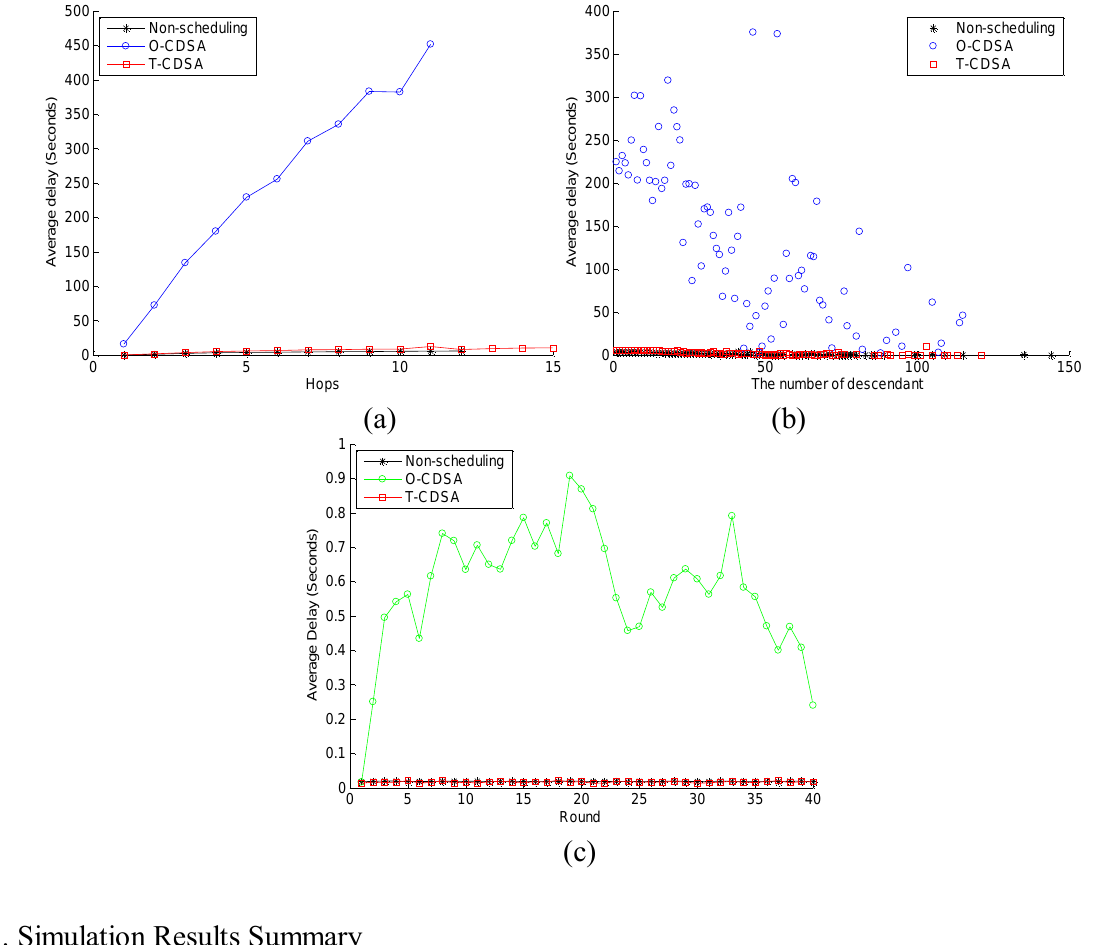
Figure 13. Delay of the three schemes: (a) Average delay versus the nodes’ hop. (b) Average delay versus the number of descendants. (c) Average delay at each